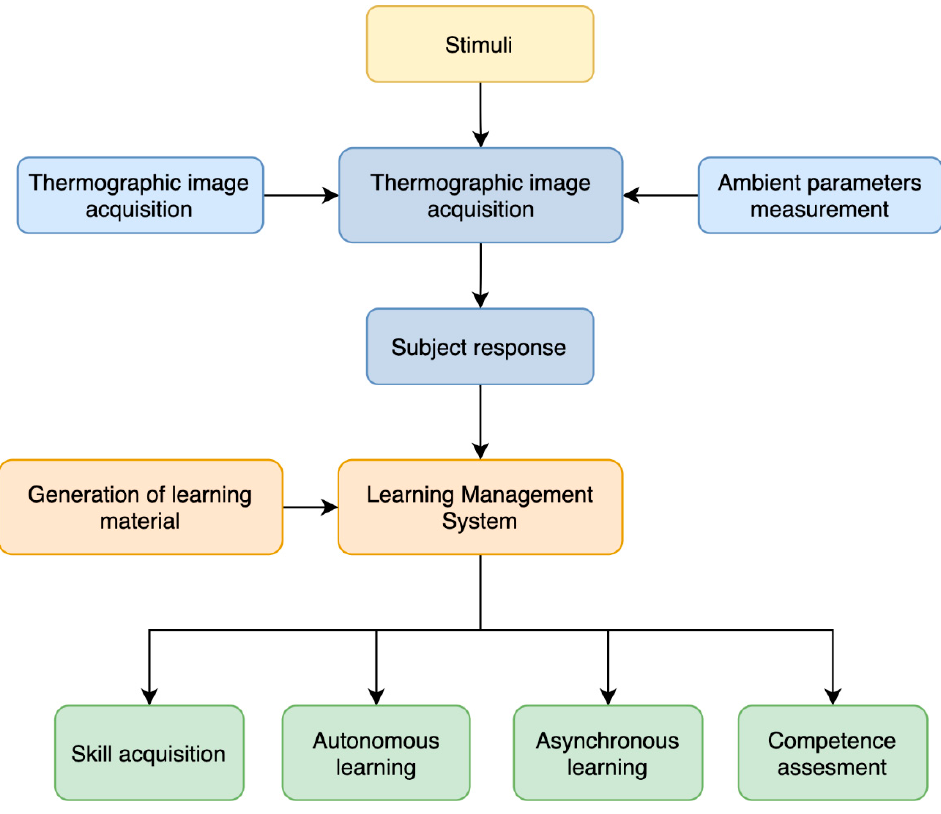
Figure 1. Flow graph of the proposed learning approach.